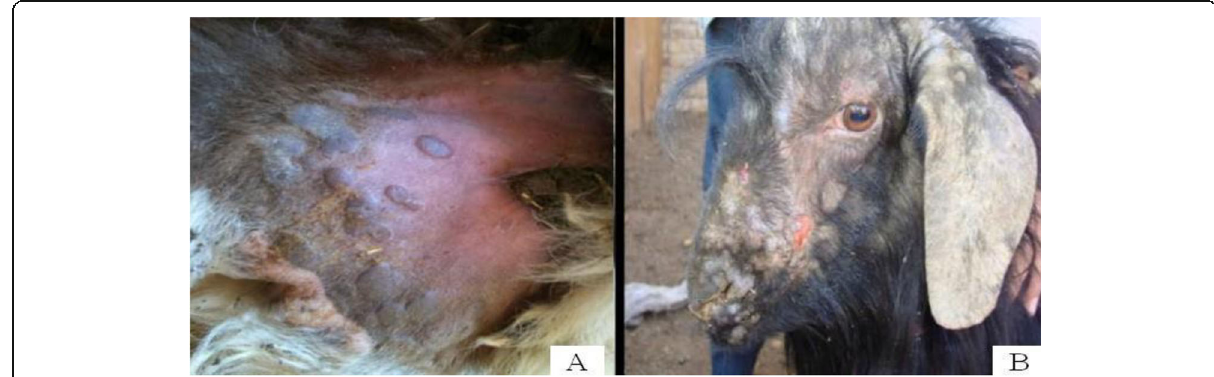
Fig. 4 Popular lesions under the tail ( A ). Source (Zangana and Abdullah 2013). Pox lesions on the face and ears ( B ). Source (Mirzaie et al.